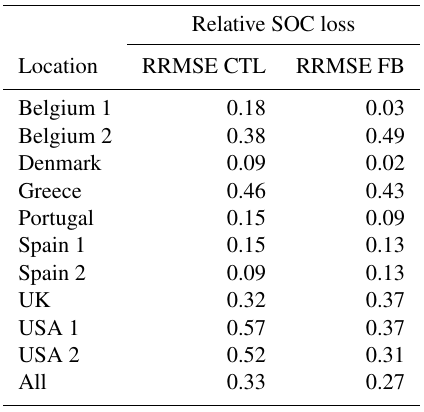
Table 2. RRMSE of CTL (control dataset, no effect of erosion on crop productivity assumed) and FB (feedback dataset, effect of erosion on productivity included) dataset for each location and as well as the RRMSE of each dataset, including all observations (all). RRSME is calculated over the whole 1m profile between observed and optimized SOC profile.